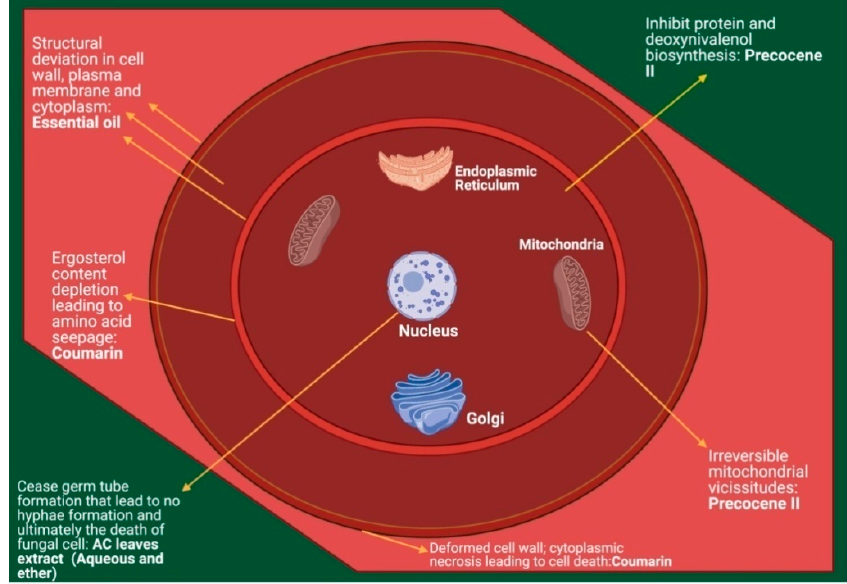
Figure 4. Effect of various Ageratum oil/constituents/extracts on fungal cell morphology. Later, with the help of affinity magnetic bead technique and recognized a protein of mitochondrial outer membrane, Furukawa et al. [93] explored the molecular progression by which precocene II tended to inhibit trichothecene fabrication in F. graminearum , with the voltage-dependent anion channel (VDAC) as the precocene II-interacting protein. Pre- cocene II escalated the mitochondrial proteins (oxidized) concentration and superoxide level in mitochondria, which led to the discontinuation of trichothecene production in the key causal agent of Fusarium head blight and trichothecene contamination in grains. Sub- sequently, several other researchers also buoyed the influence of precocene II in disturb- ing the cell structure and mitochondria of fungi, proving it to be a progressive antifungal agent. Thati et al. [116] studied the mechanism by which some silver-coumarin complexes exhibited their antifungal potential against C. albicans , a pathogenic strain. Results demon- strated a disruption of respiratory function and depletion of the ergosterol content of the fungal cell, which resulted in a deformed plasma membrane because membrane integrity and membrane fluidity are regulated by ergosterol in fungal cells. This sequence of pro- cesses enhanced the trans-membrane seepage of the amino acids, leading finally to apop- tosis. These upshots were further supported by the findings of Widodo et al. [102], who performed scanning electron microscope (SEM) and transmission electron microscope (TEM) analysis to study the influence of coumarin on C. albicans that was isolated from A. conyzoides . This exploration confirmed that the compound damaged fungal cells by pores development in the cell wall, allowing the escape and necrosis of cytoplasmic content, leading to death. Remarkably, the anti-candida mechanism reported for coumarin was different from other antifungal extracts obtained from medicinal plants such as Swietenia mahogany and Barleria grandiflora [117,118]. Having been established on the grounds of constructive deliberations, the recom- mendation of extracts and essential oils from A. conyzoides as novel plant-based aflatoxin B 1 suppressor and antifungal agent over the conventionally used fungicides and synthetic preservatives is irrefutable. Some of the findings validating this statement are summa- rized below in Table 3.